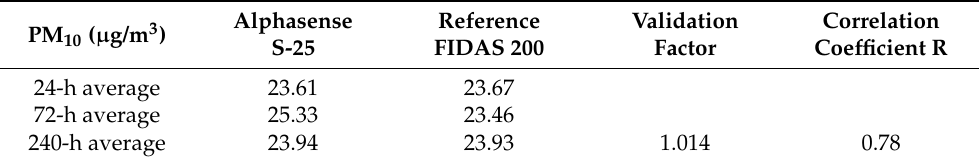
Table 7. Data used to determine the validation factor (sensor unit no.